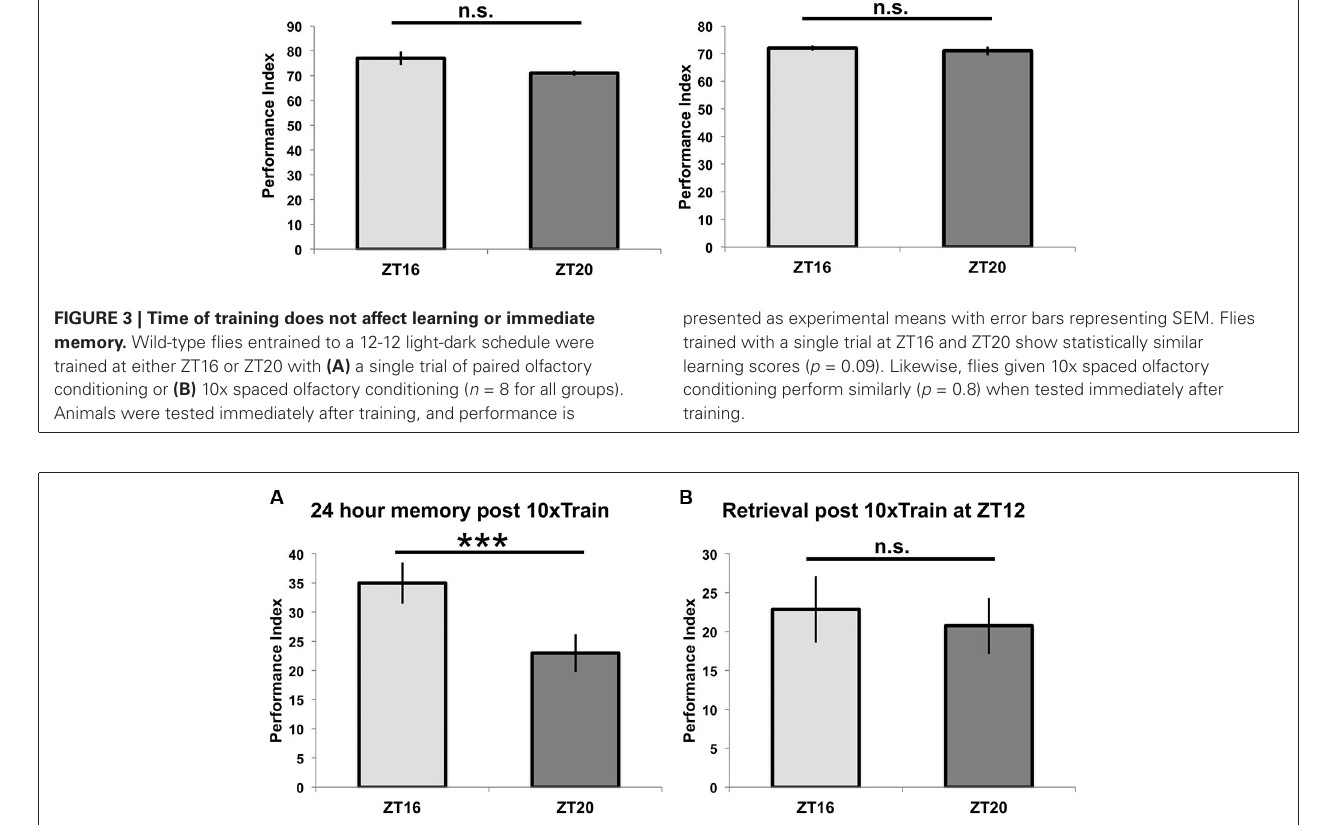
with 7x spaced conditioning (compare to Figure 2 ). (B) After entraining to a 12-12 light-dark schedule, wild-type flies were trained at ZT12 with 10x olfactory conditioning and tested for memory retention on the following day at ZT16 or ZT20 ( n = 8 for both groups). Flies tested at different times showed statistically similar memory retention ( p = 0.7). Data are presented as experimental means and error bars indicate